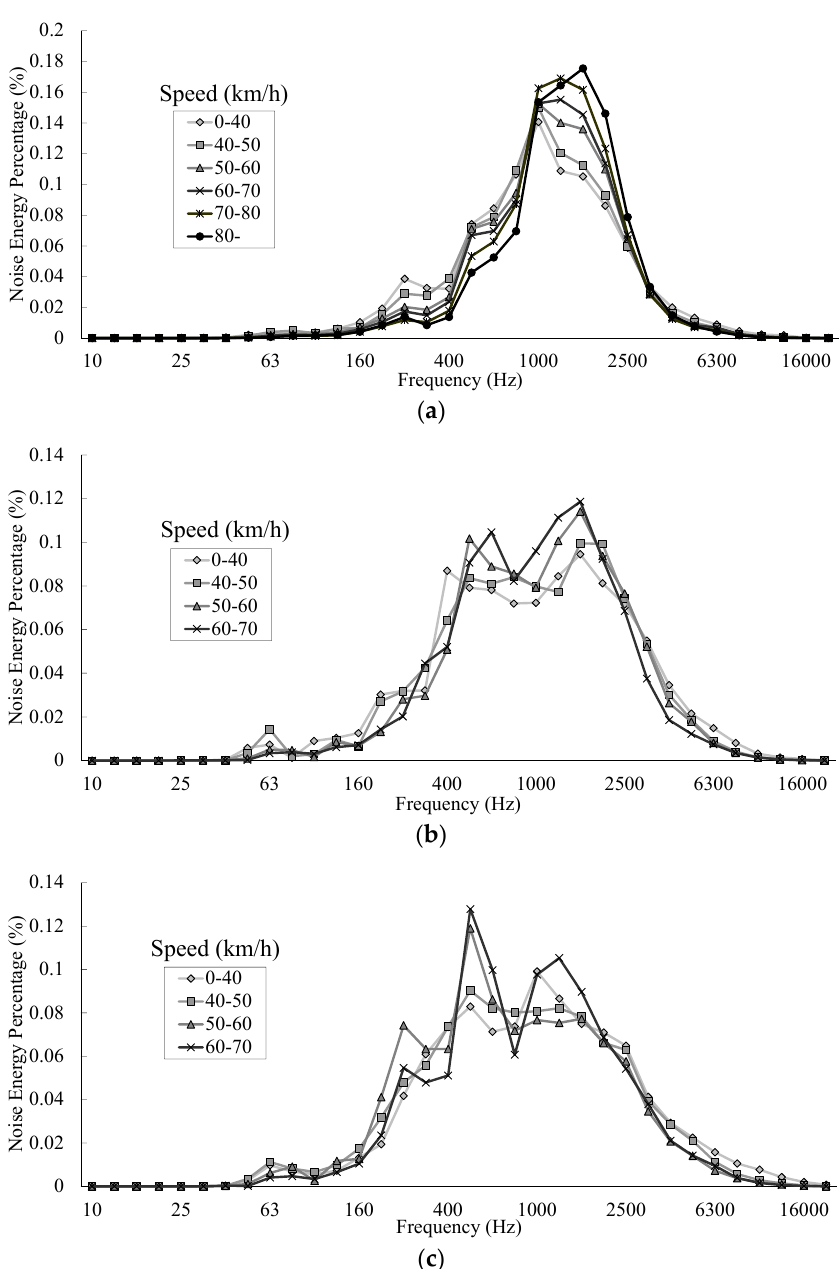
Figure 2. Noise energy percentage with the 1/3rd octave band spectrum frequencies at different speeds of three types of vehicles. ( a ) light vehicles; ( b ) middle vehicles; ( c ) heavy vehicles.